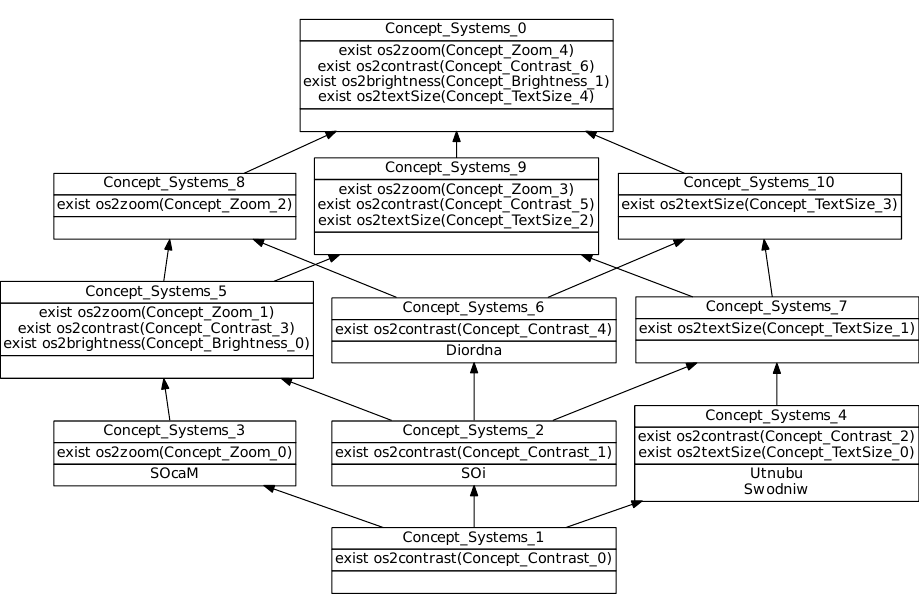
Figure 8. Concept lattice of Operating System accessibility options. In figures that correspond to RCAexplore tool output, quantifiers appear as plain text (e.g., exist ) rather than symbols (e.g., ∃ ) to avoid encoding